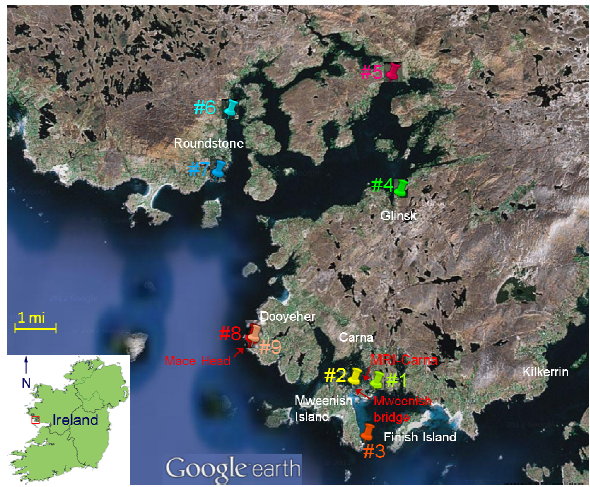
Fig. 1. The denuder sampling sites on the west coast of Ireland (revised from Google earth).